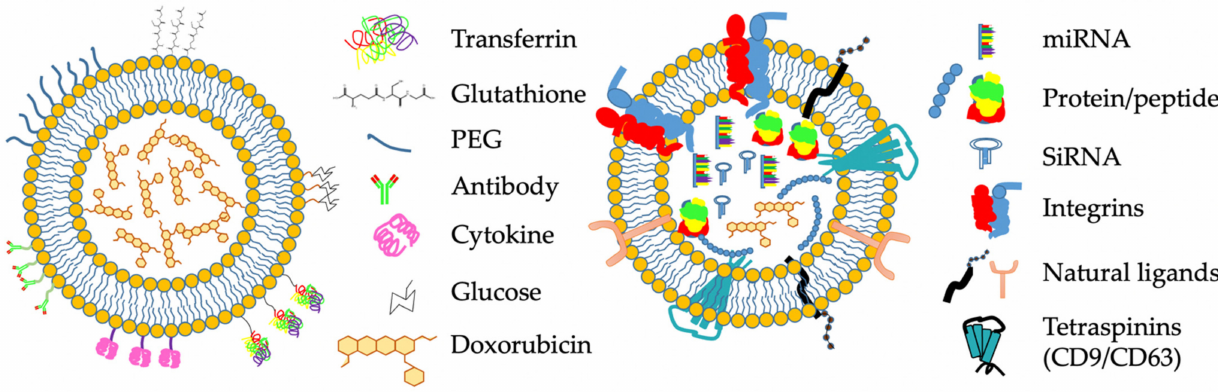
Figure 2. Liposomes and exosomes as BBB-permeating drug nanocarriers. Left : Schematic diagram of a liposome. In the simplest form, a liposome comprises a lipid bilayer membrane and a drug payload (e.g., Doxorubicin, shown here). Liposomes are commonly modified with poly(ethylene glycol) (PEG) to improve circulatory properties. As means of improving BBB specificity, substrates such as cytokines, glucose, transferrin or glutathione can be conjugated onto the liposome surface. Antibodies against specific targets may be added. Right : Schematic diagram of an exosome. Exosomes are membrane-bound vesicles approximately 100 nm diameter. Their surface is decorated with a variety of natural ligands and receptors, which may have targeting properties. Exosomes contain naturally occurring payloads of proteins, peptides and nucleic acids (miRNA, siRNA etc.). They may also be loaded with exogenous compounds, such as Doxorubicin. Their overall complexity is far greater than